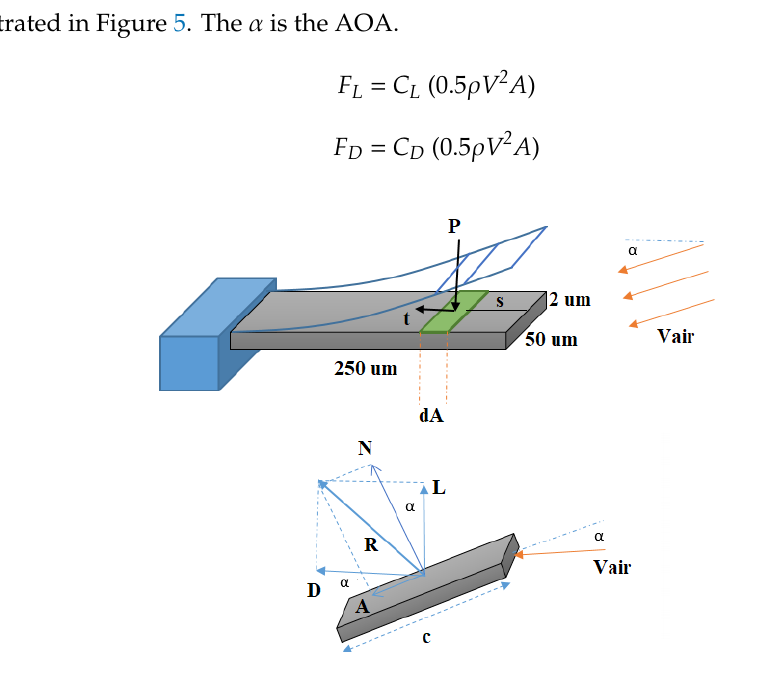
Figure 5. A demonstration of a force diagram of airflow and microcantilever interaction that is used in mathematical modeling. L is the lift force. D is the drag force. N is a normal force to surface elements. A is a tangential force along with the surface element. P is the vertical pressure force. T is the shear force acting on the surface.